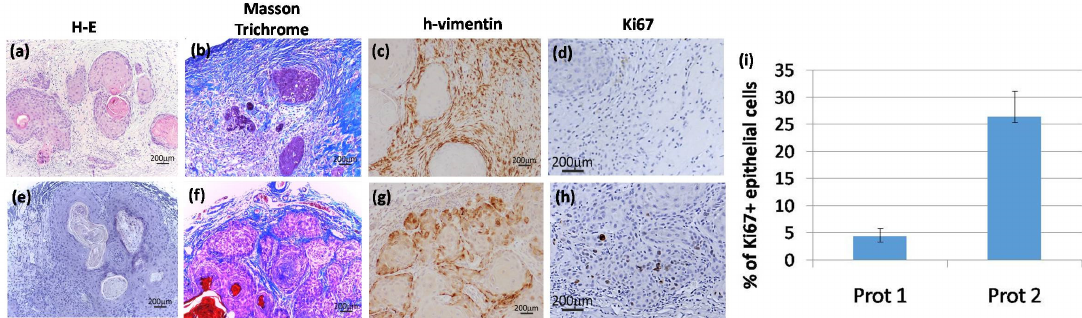
Figure 4. Histopathological analysis of representative tumors generated by different protocols of SCC stroma humanization. ( a–d ) Protocol 1; ( e–h ) protocol 2; ( a ) and ( e )hematoxylin-eosin staining shows the structure of the tumors developed, as evidenced by the presence of tumor nests and cornified pearls and blood vessels in protocol 2; ( b ) and ( f ) Mason trichrome staining shows the different humanized tumoral stroma in both protocols;( c ) and ( g ) show the human origin of fibroblasts surrounding the tumor structure by a h-vimentin staining; ( d ) and ( h )show that tumors developed by protocol 2 have more proliferative cells as shown by a Ki67 staining.( i ) Shows a quantification of the epithelial component of the tumor where ki67 + nuclei/100 epithelial cells is shown. For this calculation a total number of ten representative fields were included. Images are representative results for each group ( n = 3). Scale bars 200 μ m.